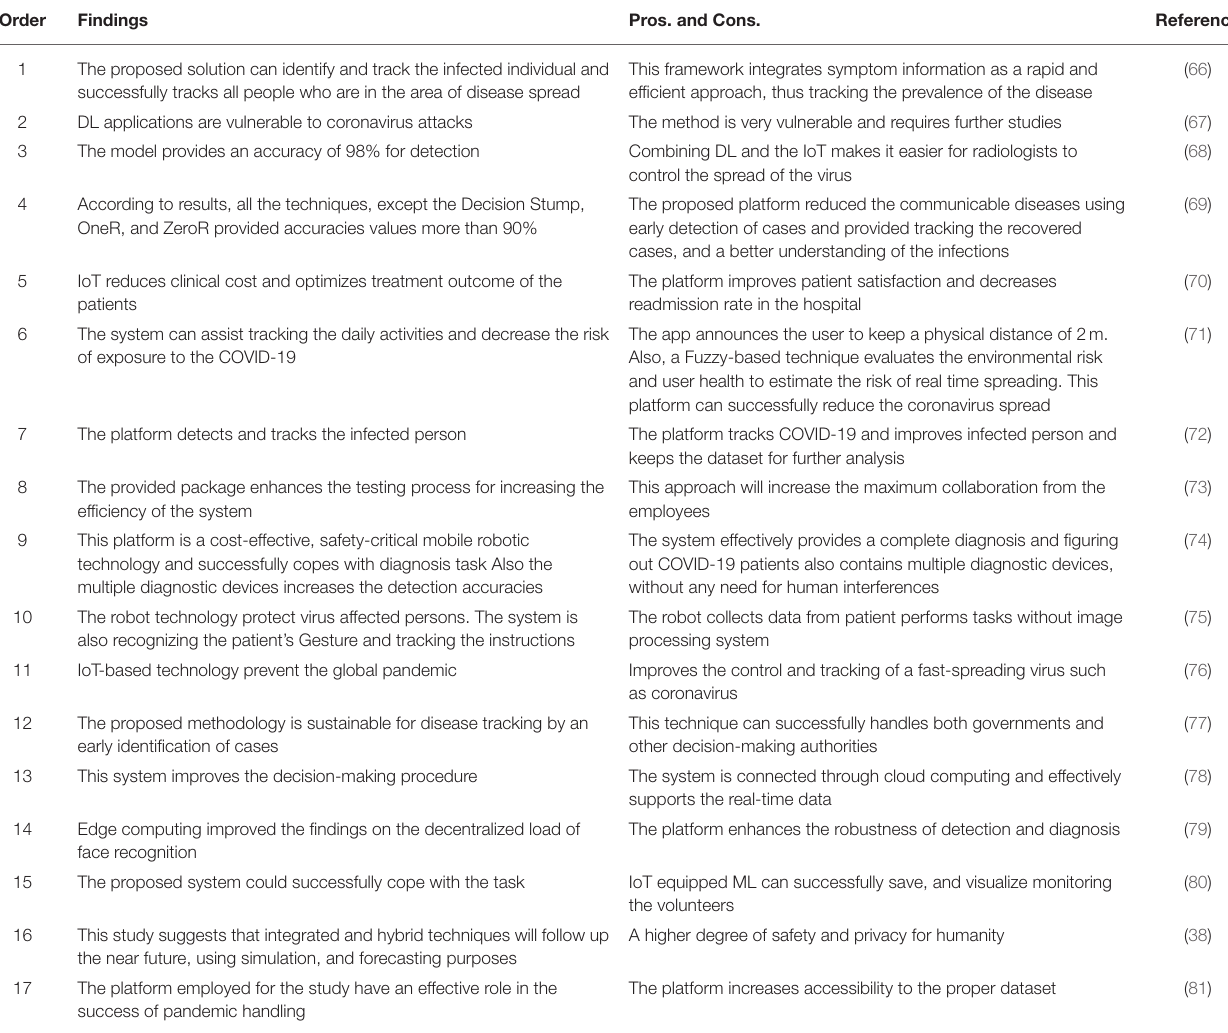
TABLE 8 | The main findings of the study for the application of IoT-based techniques. Order Findings Pros. and